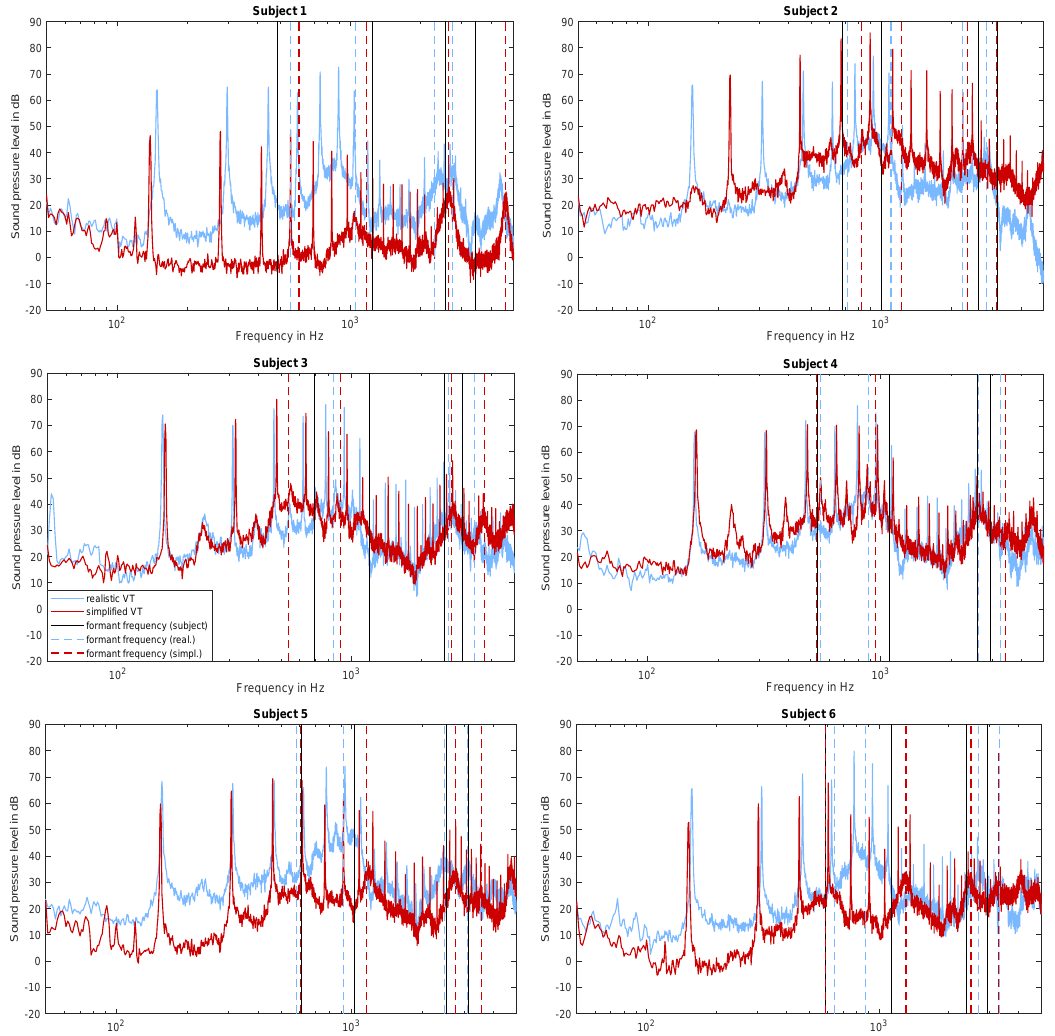
Figure 5. SPL of the sound emitted by vocal fold replicas coupled with MRI-based VT replicas from six subjects. Realistic geometries (blue curve) and simplified geometries with a concentric straight tube approximation (red curve) are shown for each individual. The formant frequencies are marked with vertical lines. The applied detection method for all formants is based on inverse filtering, as described in Section